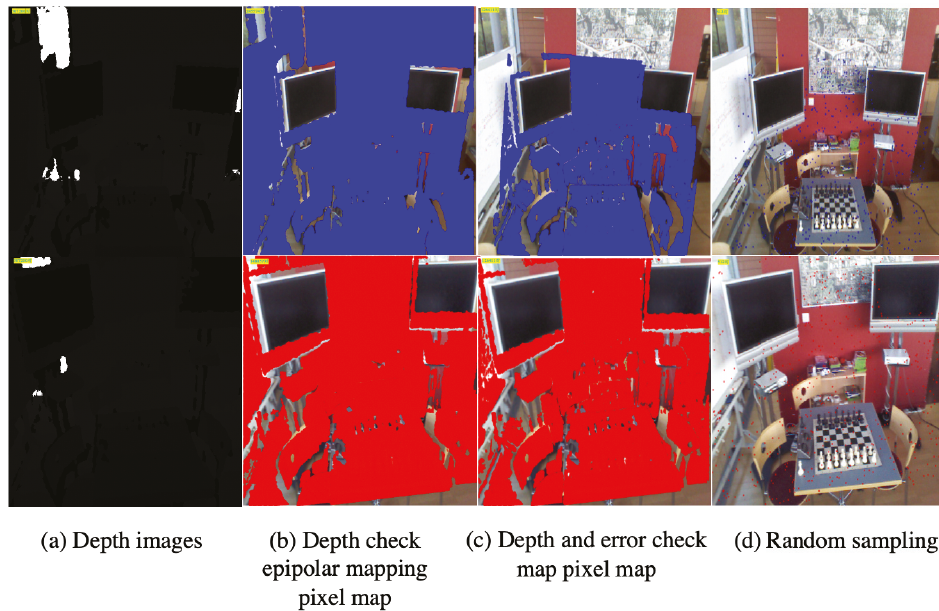
Figure 10. The calculation process of the corresponding relationship between image